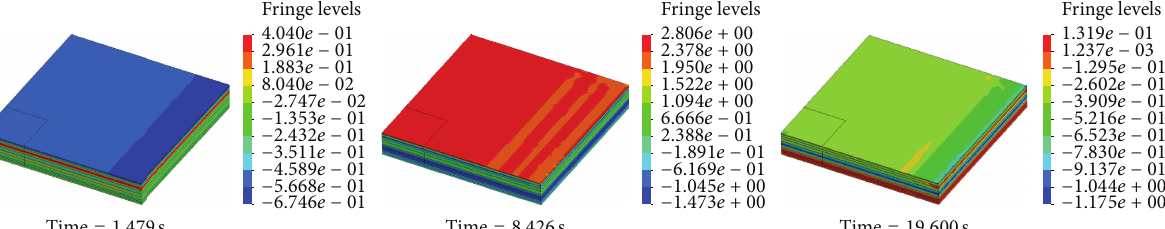
Figure 8: Instantaneous 𝑋 -component acceleration fields of the free field (MCH000, 𝑆𝑋 ).